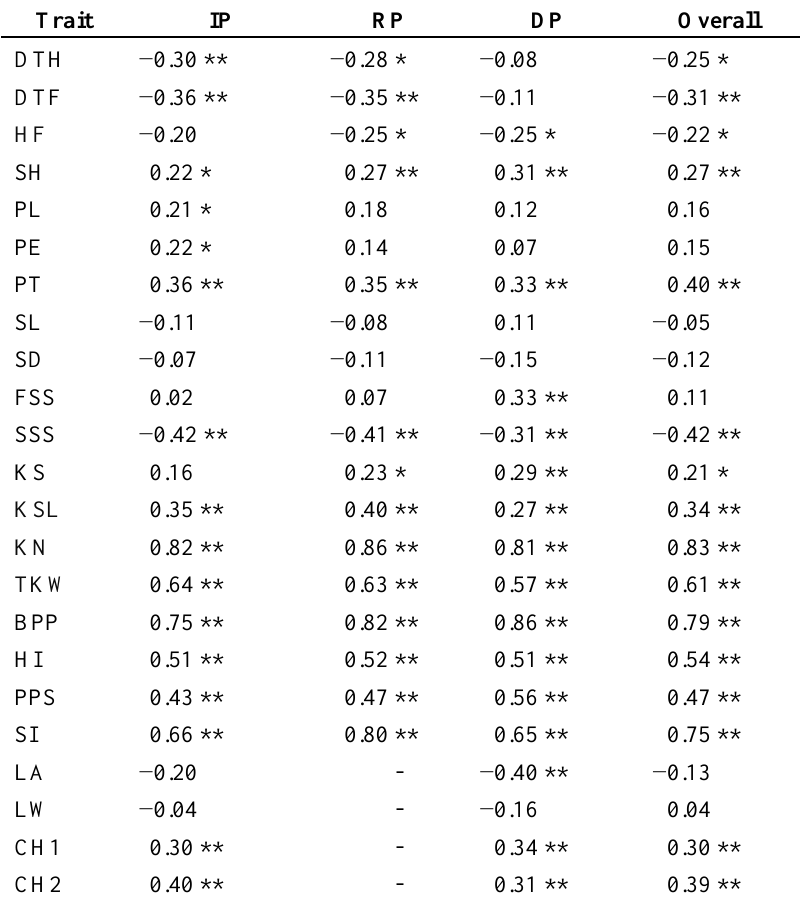
Table 3. Genetic correlation between grain yield and 23 other traits in irrigated (IP), rainfed (RP) and drought (DP) plots (averaged over years) and overall (averaged over years and